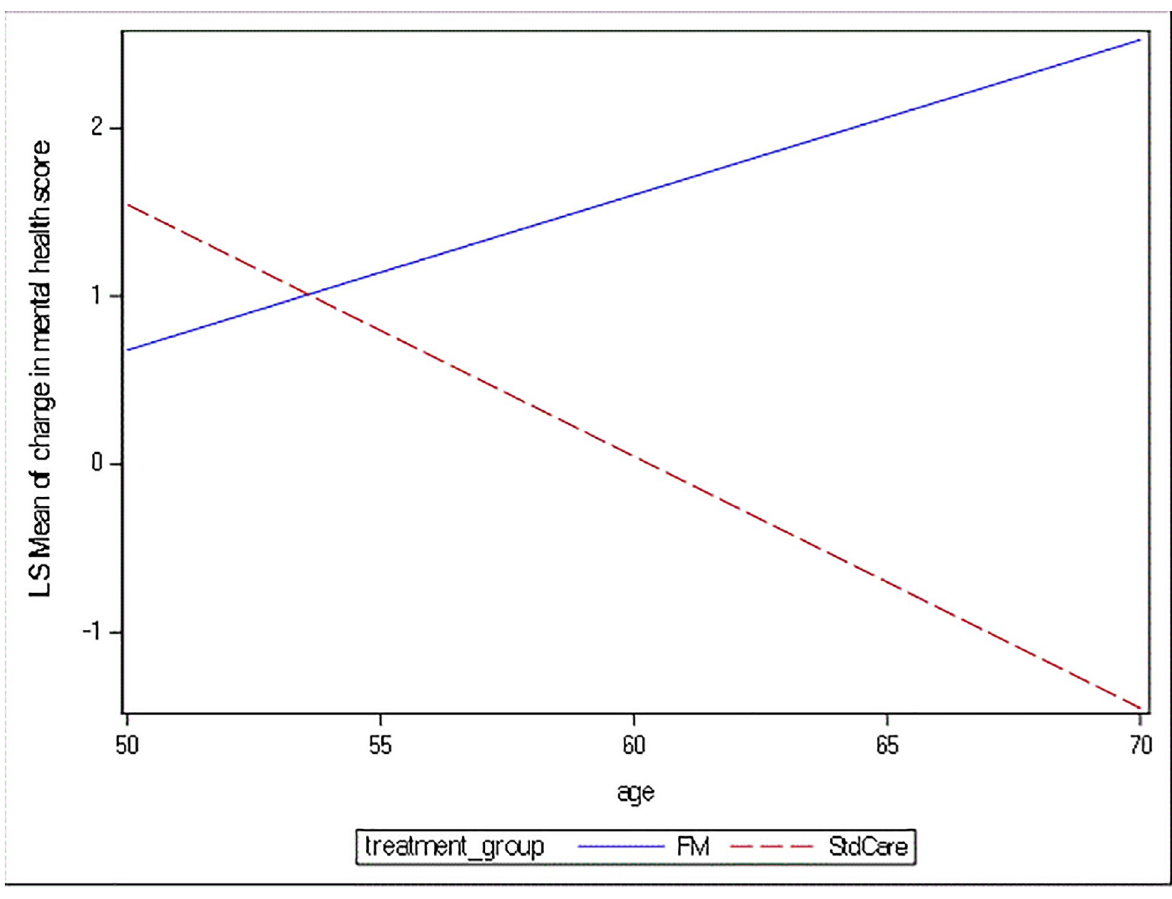
Fig 1. Mean change in mental health score vs.